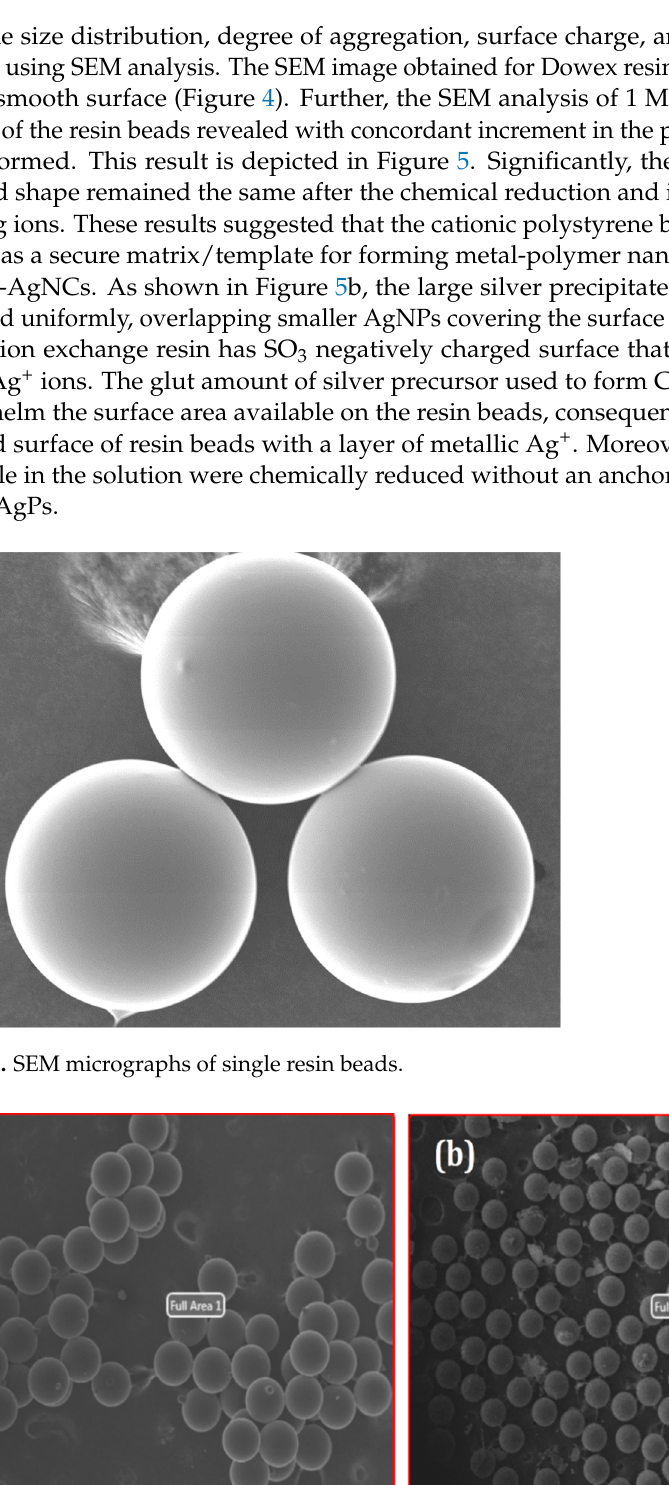
Figure 3. ( a ) UV-Vis absorption spectra of successive formation of CR-AgNCs dispersed in water. Reaction conditions: [Dowex ® 50WX2] = 1 g; [AgNO 3 ] = 1 mM to 1 M; [NaBH 4 ] = 2 mM to 2 M. ( b ) Integrated UV-Vis spectra of Dowex ® 50WX2 resin beads.